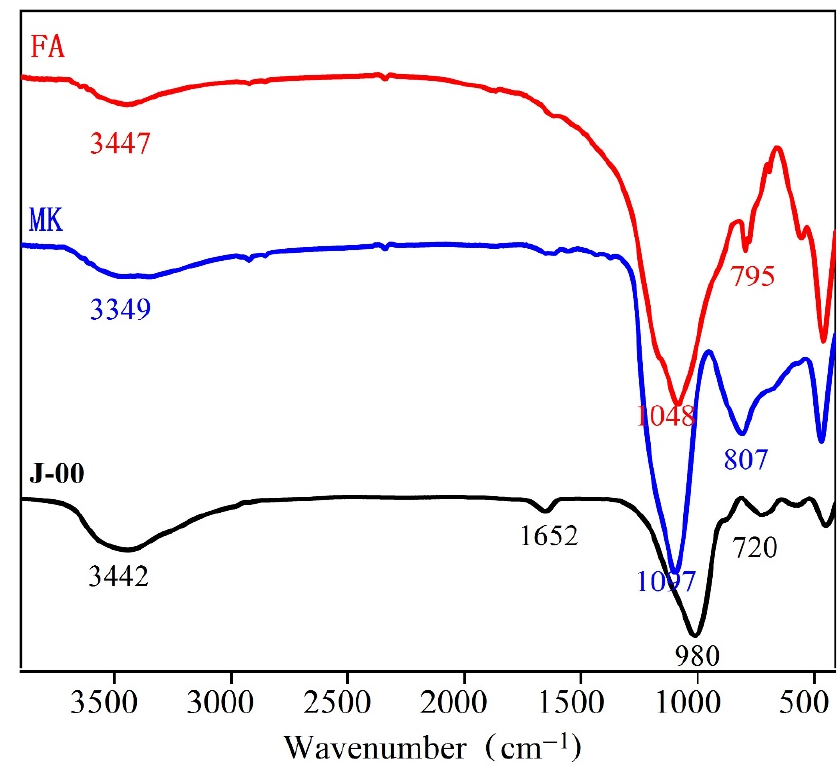
Figure 5. Infrared spectra of FA, MK, and geopolymer paste of J ‐ 00.